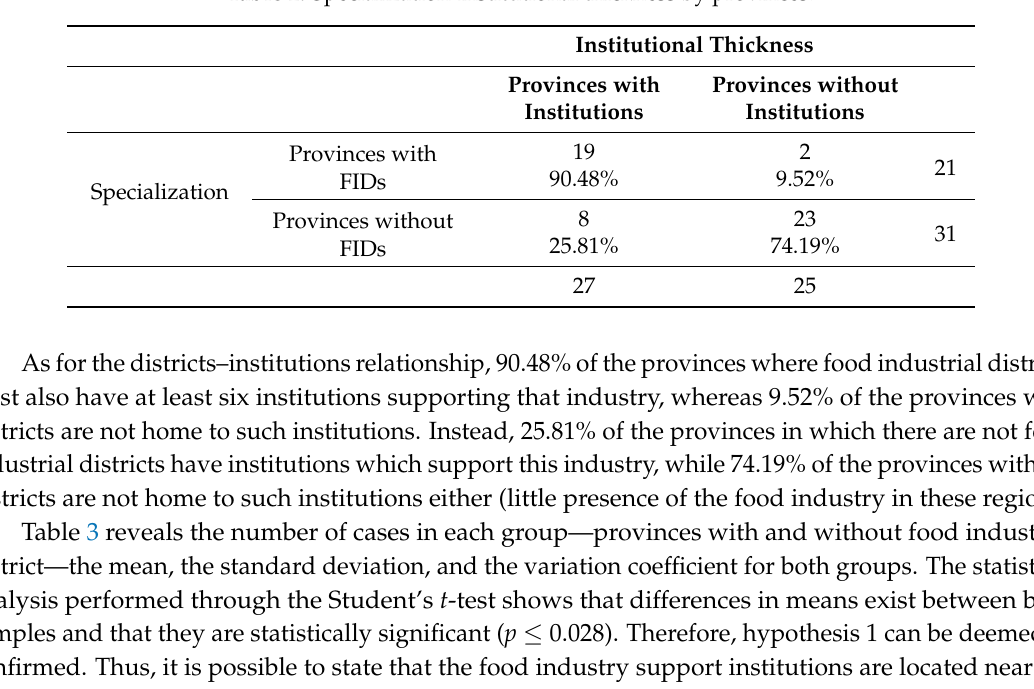
Table 2. Specialization-institutional thickness by provinces.